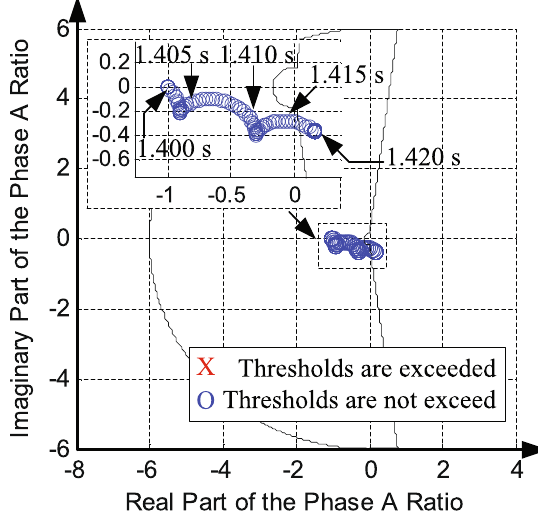
Fig. 10 Calculated current phasor ratio trance of event 2: internal high impedance fault, grid-connected mode